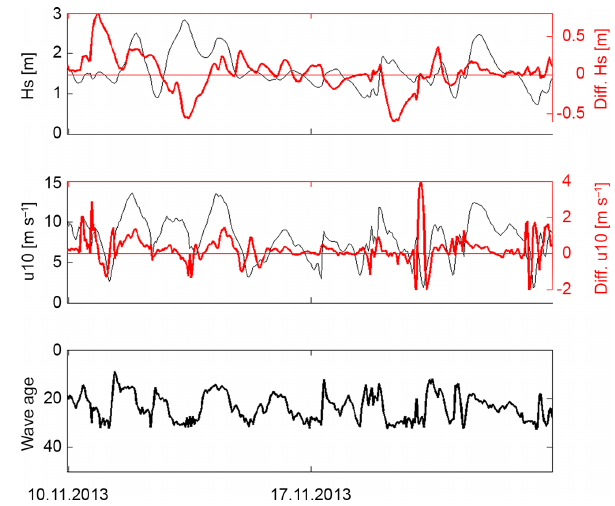
Figure 12. Time series of significant wave height (m, top panel), wind speed (ms − 1 , middle panel) and wave age (bottom panel) from the two-way coupled German Bight set-up at FINO-1 for (a) a rather calm period with young wind sea and (b) during storm Xaver). Red lines in the top and middle panels show the differences between the one-way and two-way coupled